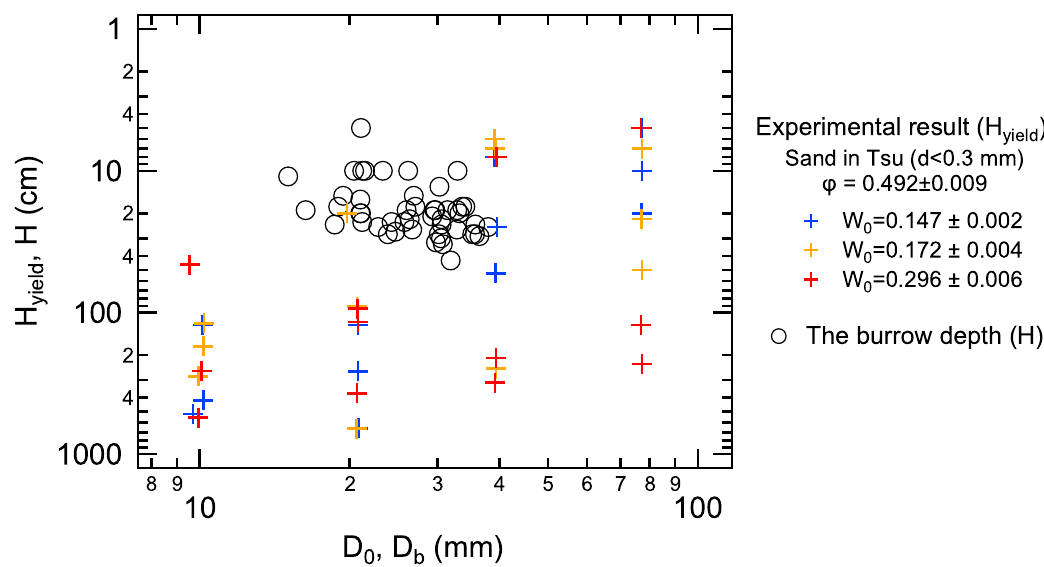
Fig 13. Relationship between tunnel diameter and depth of actual burrows (circles) and an experimentally obtained pressure yielding depth H yield (plus marks). Tunnel diameter ( D 0 ) relationship with H yield was computed from experiments (plus marks) with sand collected at the Tsu site of grain diameter d < 0.3 mm. Colors differentiate various water contents in sand ( W 0 ). Circular symbols indicate the relationship between the thickness of sand overburden ( H ) and tunnel diameter ( D burrows observed in the field.